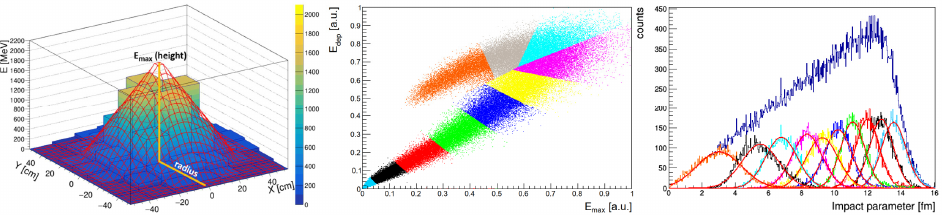
Figure 2. Left — the two-dimensional linear fi t of the histogram with energies deposited in each FHCal module. Middle —the correlation between the maximum energy (height of the fit cone) and the deposited energy in the FHCal. Different colors denote 10% centrality classes. Right — impact parameters distributions for each 10% centrality class fitted with Gaussian. Colors of the fit lines coincide with ones of the centrality classes in middle panel.